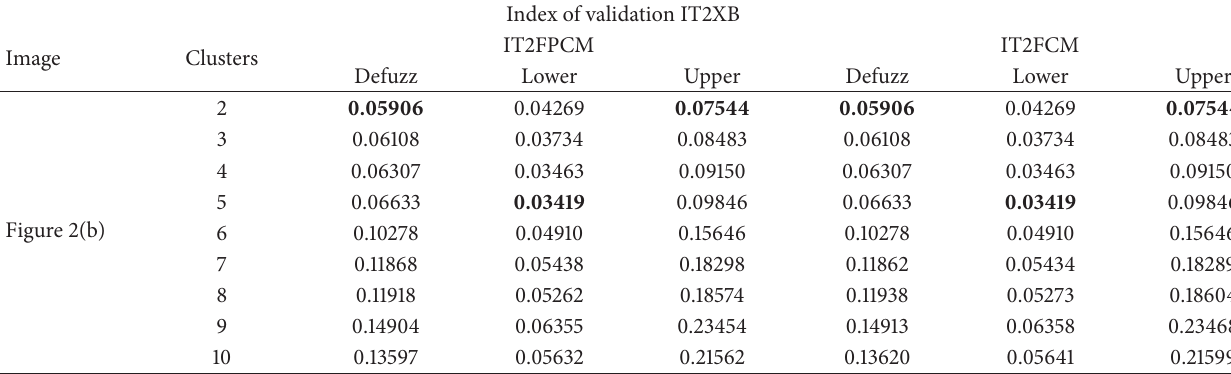
Table 31: Results of the IT2XB validation index to the clustering of image shown in Figure 2(b) using IT2FPCM and IT2FCM algorithm with 𝑚 = [1.5, 2.5] and 𝜂 = [1.5, 2.5] as